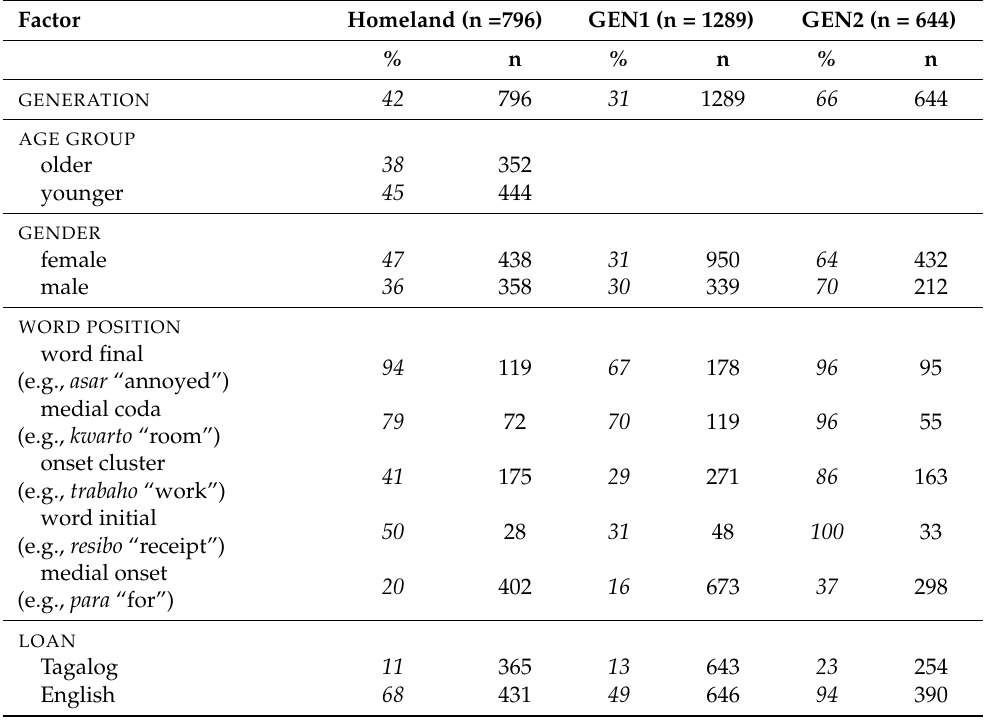
Table 5. Rates of use of the approximant according to social and linguistic factors (n = 2729). Factor